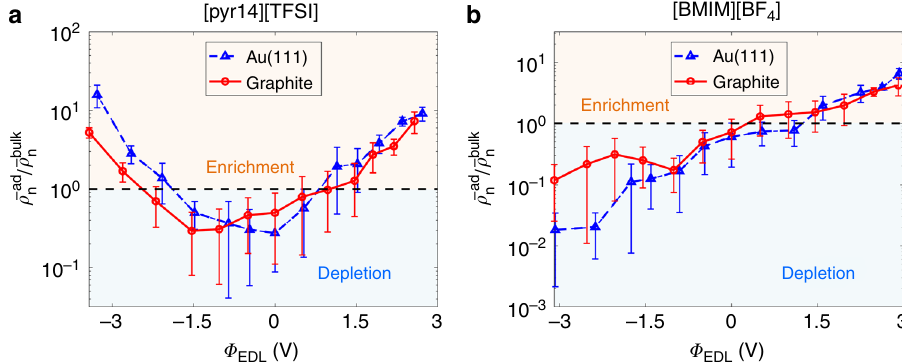
Fig. 2 Electrosorption of water from humid ionic liquids on electrodes. a , b show water adsorption from the humid 1-butyl-1-methylpyrrolidinium bis (tri fl uoromethylsulfonyl)imide ([pyr14][TFSI]) and 1-butyl-3-methylimidazolium tetra fl uoroborate ([BMIM][BF 4 ]) with respect to the electrical double layer potential ( Φ EDL ), respectively; results for gold electrode are shown by blue triangles and for carbon electrode by red circles. The relative enrichment or depletion of water molecules in the fi rst interfacial layer is depicted by the ratio of averaged number density of water in this layer to that of water in the = (cid:1) ρ bulk bulk region ( (cid:1) ρ ad ). Enrichment (depletion) zone corresponds to a higher (lower) water density than in the bulk. The error bars are due to the standard n n deviation of the results based on three independent simulation cases. Source data are provided as a Source Data fi